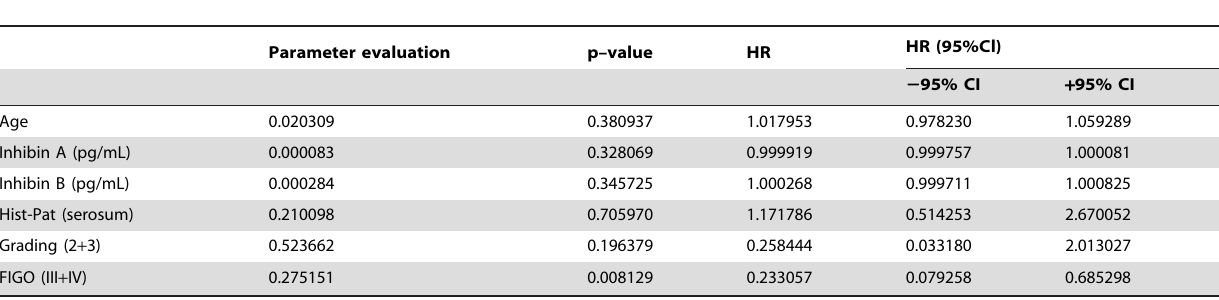
Cl: confidence interval; FIGO: Federation Internationale de Gynecologie et d’Obstetrique; HR: hazard ratio. doi:10.1371/journal.pone.0090575.t007 PLOS ONE |